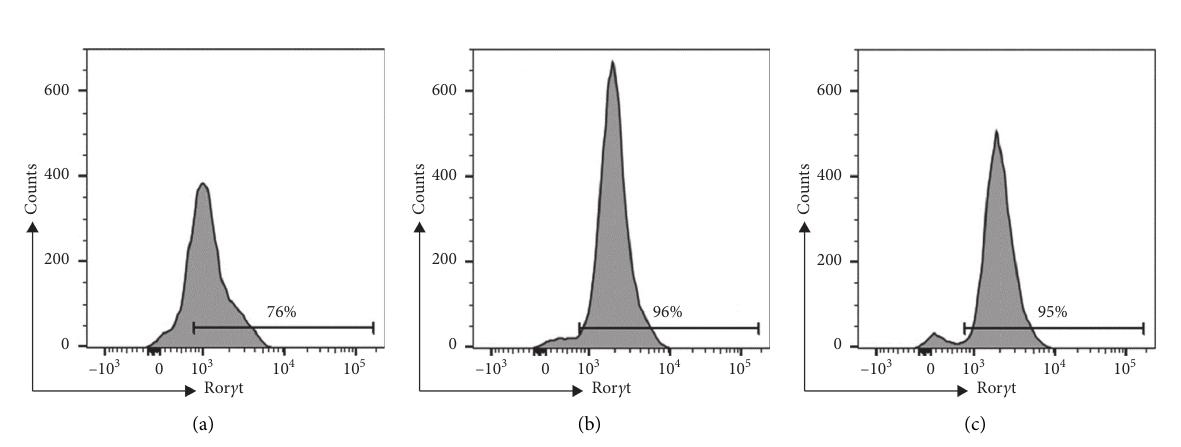
Figure 1: Representative histogram of Ror c t expression in patients with chronic hepatitis C (a), persons with spontaneous viral clearance (b), and healthy controls